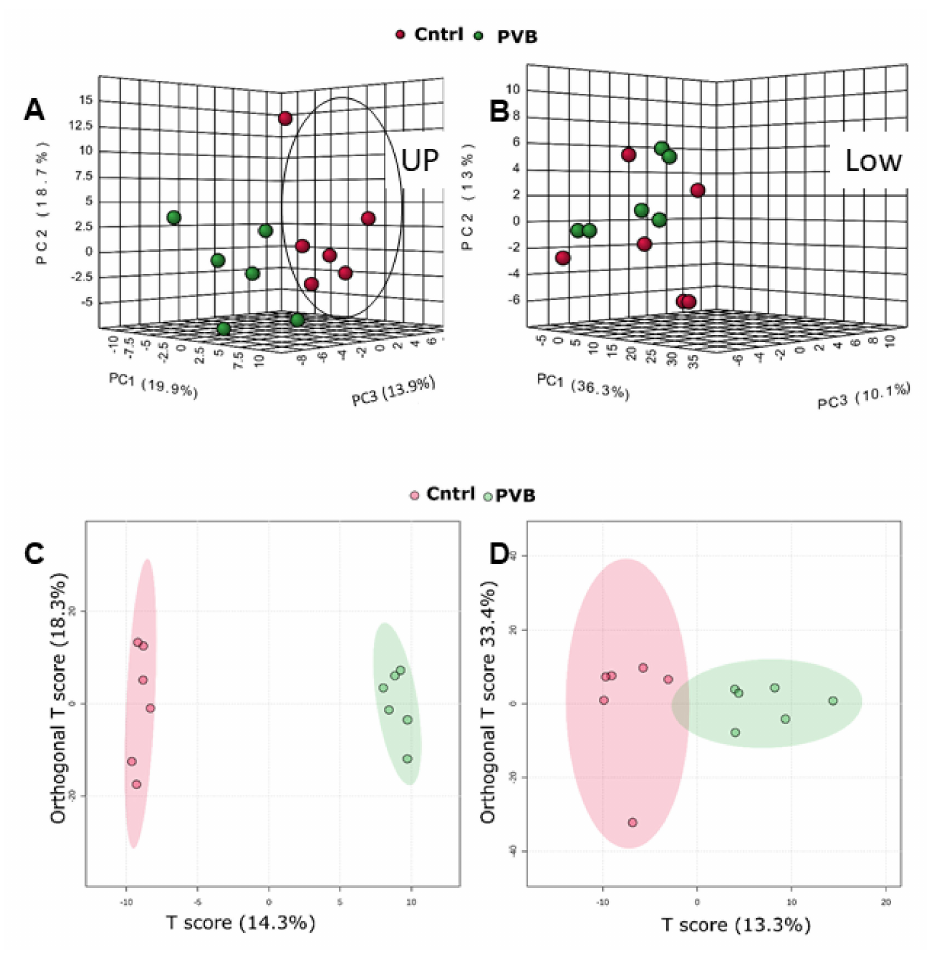
Figure 4. Metabolomic analysis in the upper and lower lobe of PVB vs. Cntrl animals. ( A , B ) Three- dimensional PCA analysis based on metabolic profiles of PVB and Cntrl animals in the upper and lower lobe in negative mode (HILIC). ( C , D ) OPLS-DA analysis based on metabolic profiles of PVB and Cntrl animals in upper and lower lobe in negative mode (HILIC). n = 6 in each